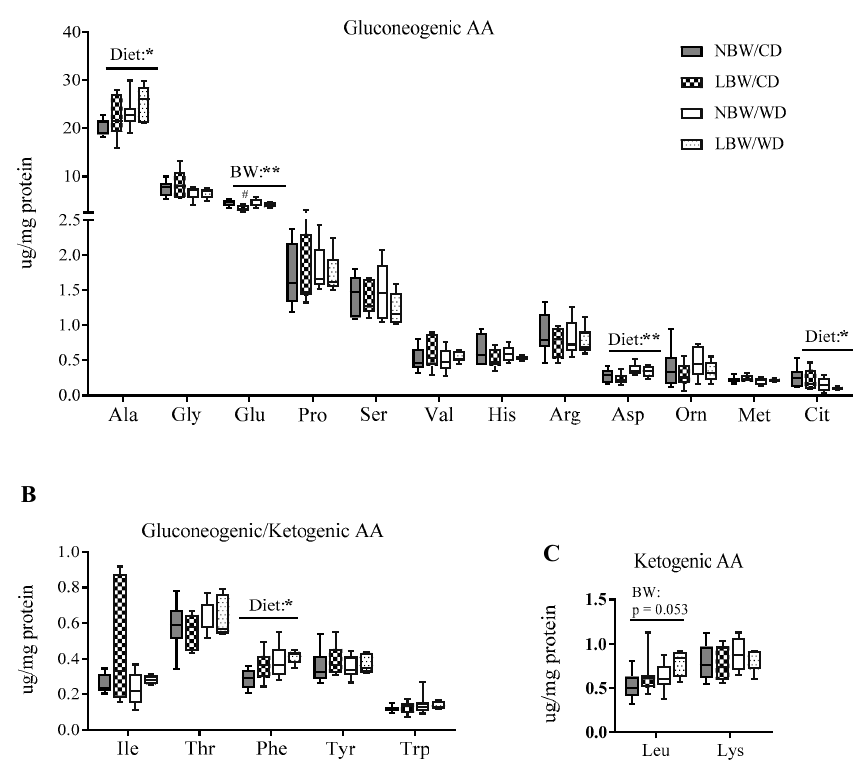
Figure 9. Amino acid (AA) concentrations in offspring’s muscle at postnatal day 145. Gluconeogenic ( A ), gluconeogenic/ketogenic ( B ), and ketogenic ( C ) AA concentrations are presented. Data are min. to max. box and whisker plots for 5 to 8 animals/experimental group. * and ** for p < 0.05 and p < 0.01, respectively, represent the main effect of birth weight (BW) or diet (Diet) using a regular two-way ANOVA. # indicates p < 0.05 and 0.01 when comparing NBW/CD versus LBW/CD using a Bonferroni post hoc test.